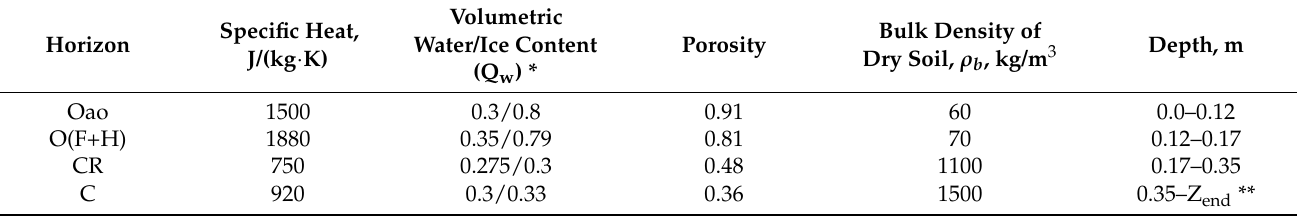
Table 1. Input parameters used for numerical simulation of the temperature regime in the soil profile. Physical characteristics of non-disturbed soils, summarized from the works in [49,50,56–59].